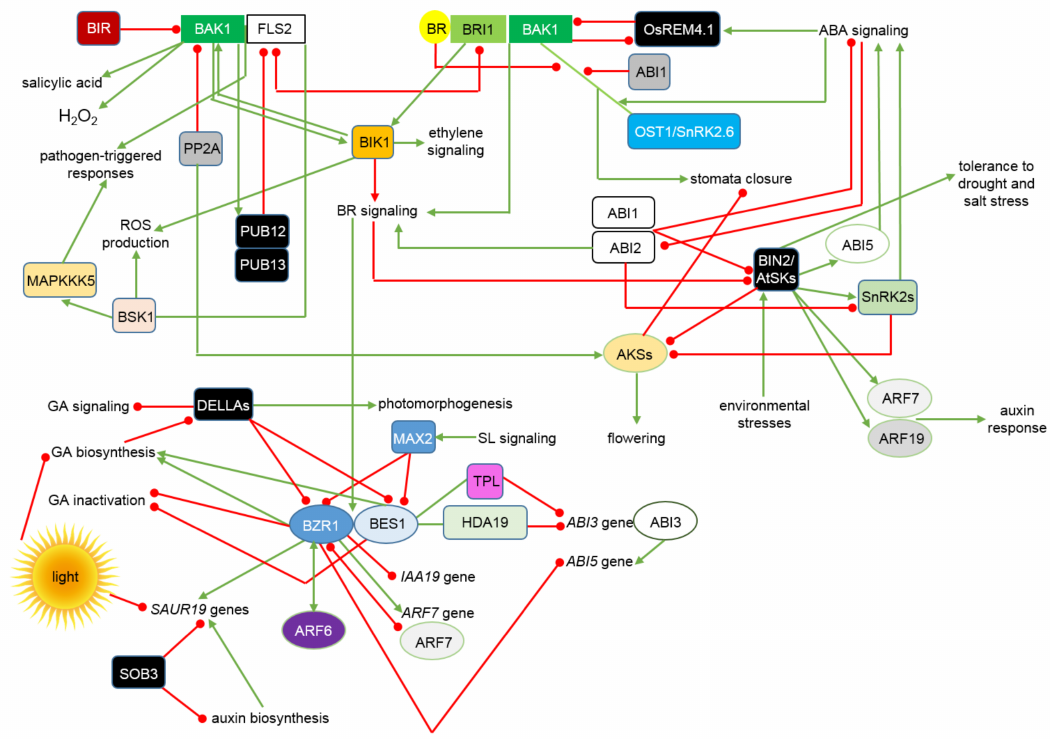
Figure 3. Crosstalk mechanism between the BR signalosome and the signaling pathways of other phytohormones. Transcription factors are shown as ovals, other proteins are depicted as rectangles. Green arrows indicate stimulation, whereas red lines with the bullet points represent suppression. Detailed description is given in the